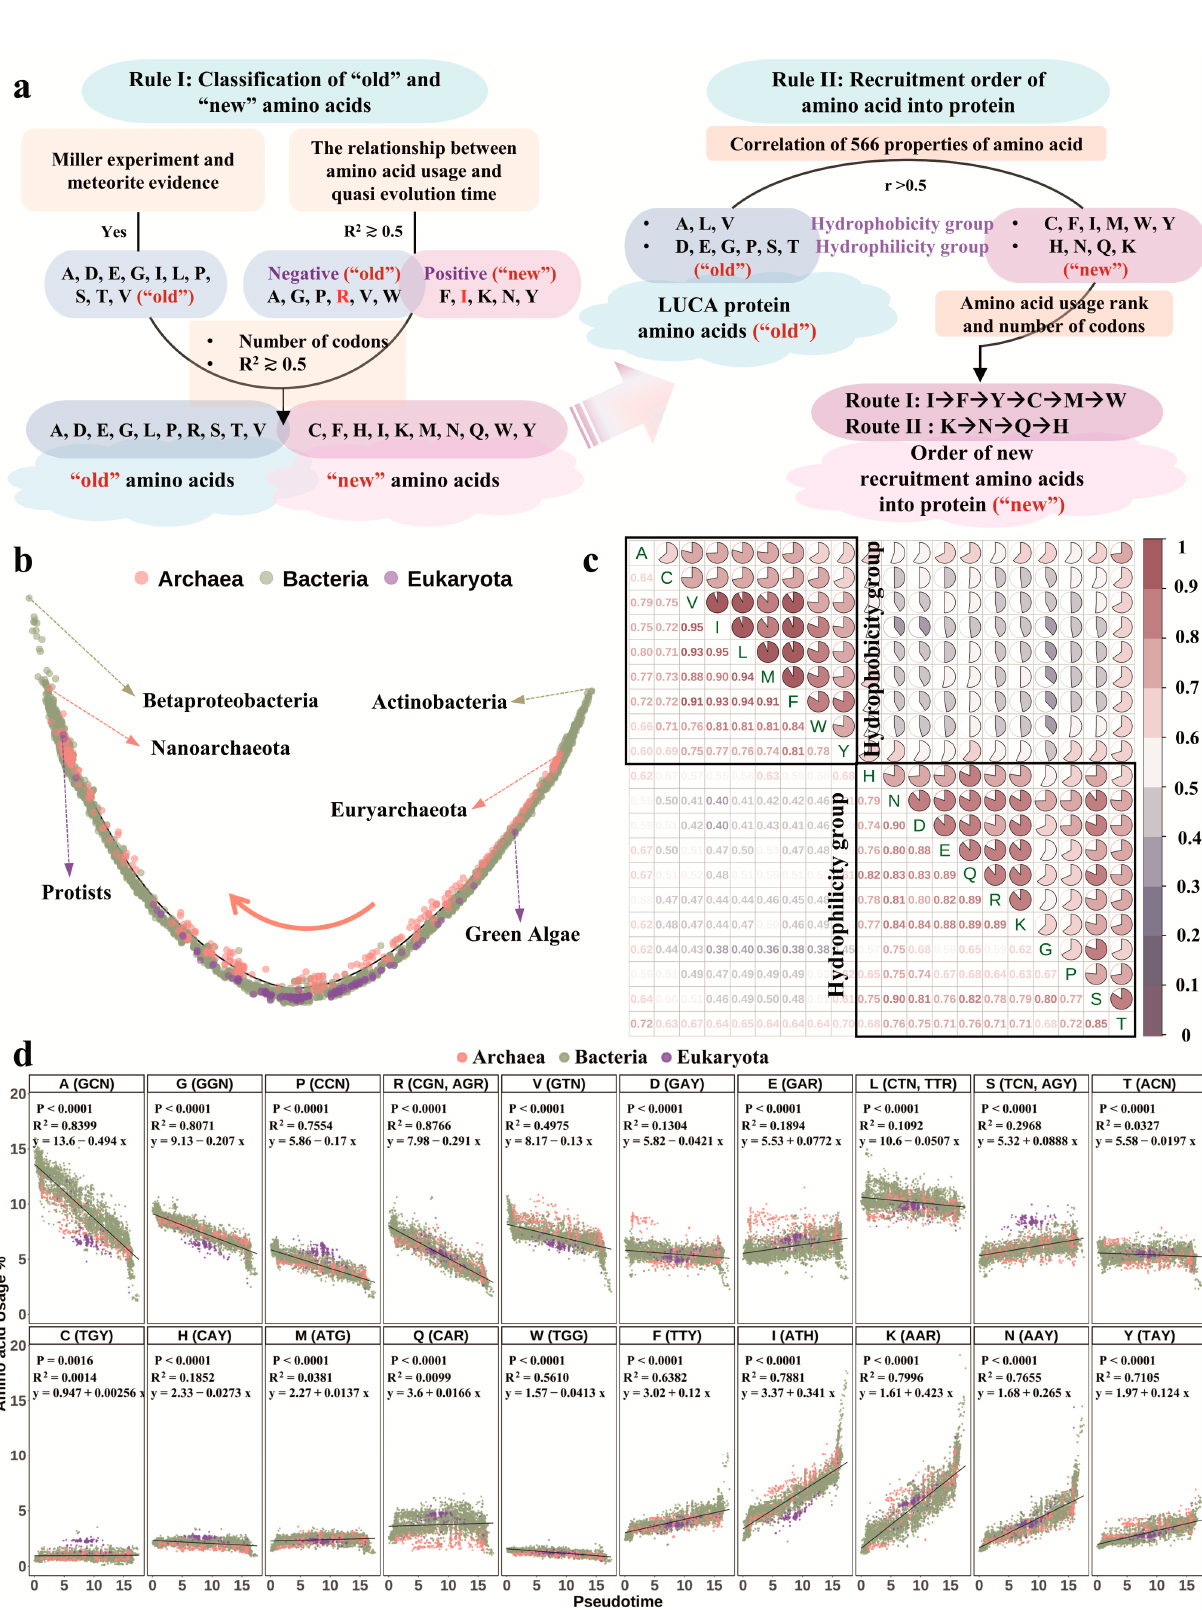
Figure 3. Amino acid composition of LUCA protein and order of recruitment of the remaining amino acids into the protein. ( a ) Overview of the classification and recruitment of new and old amino acids in proteogenesis. ( b ) Pseudotime analysis of species (monocle 2.20.0 R package). The results show the chronological order of the three domains of life as follows: Bacteria → Archaea → Eukaryota. Each